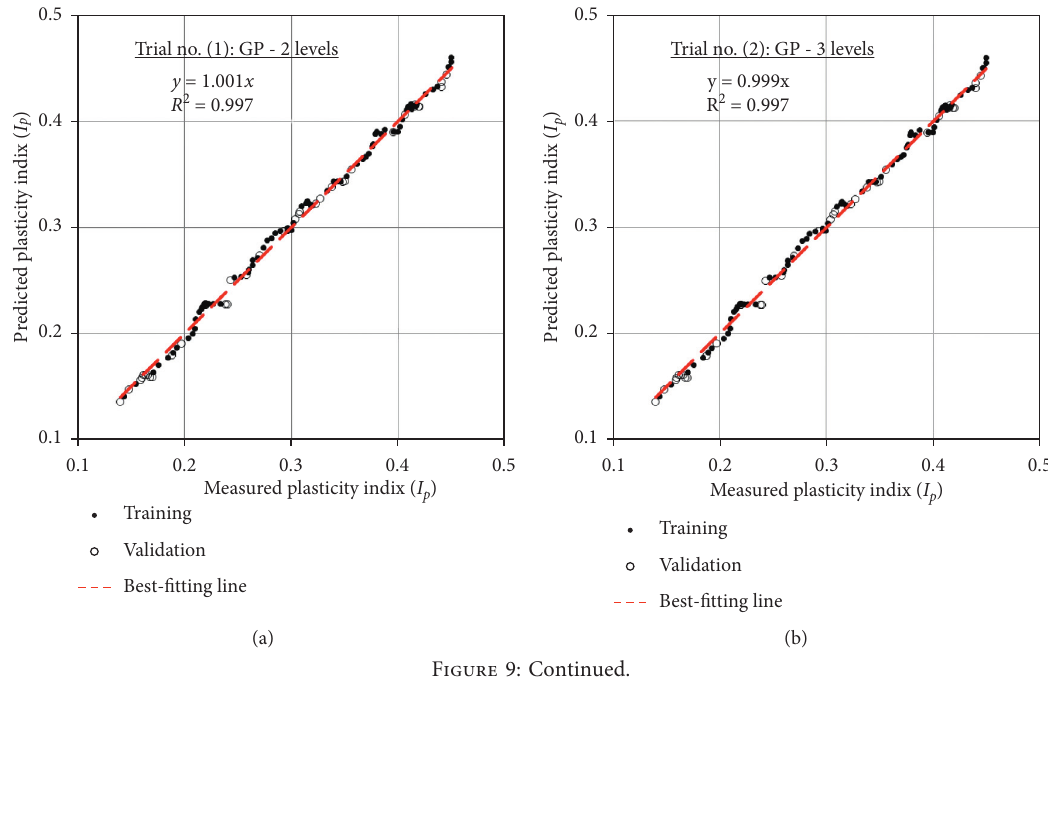
p ) values using the developed GP and ANN models.